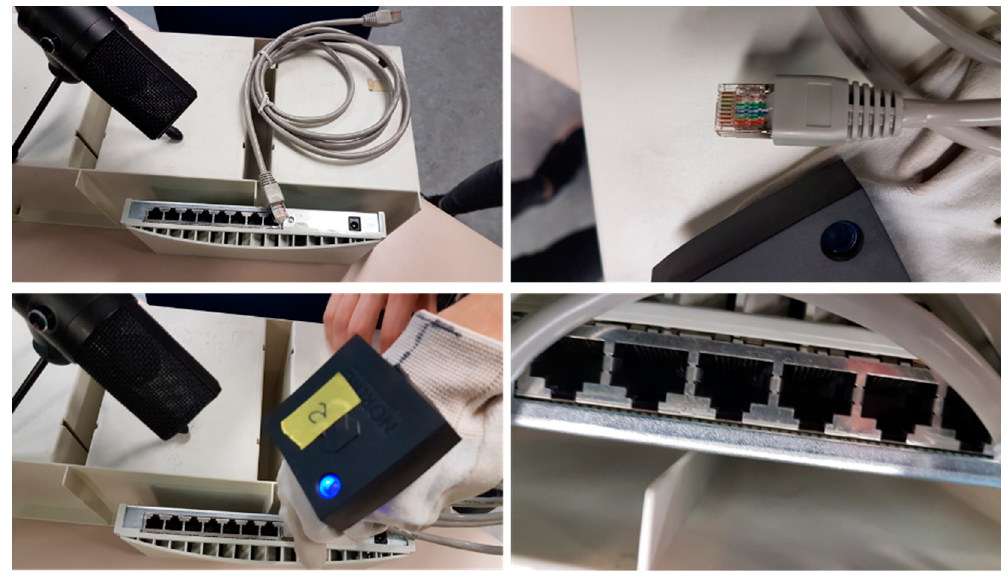
Figure 11. RJ-45 connection test bench: microphone, RJ-45 connector, sensory glove and network hub.